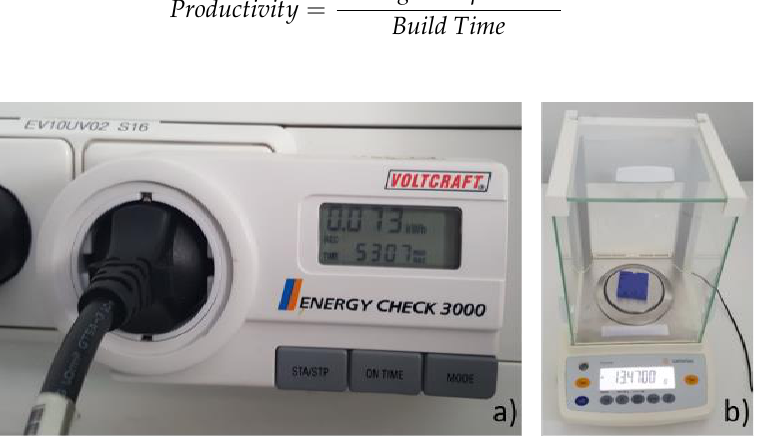
Figure 4. Stylus profilometer MarSurf GD 26.